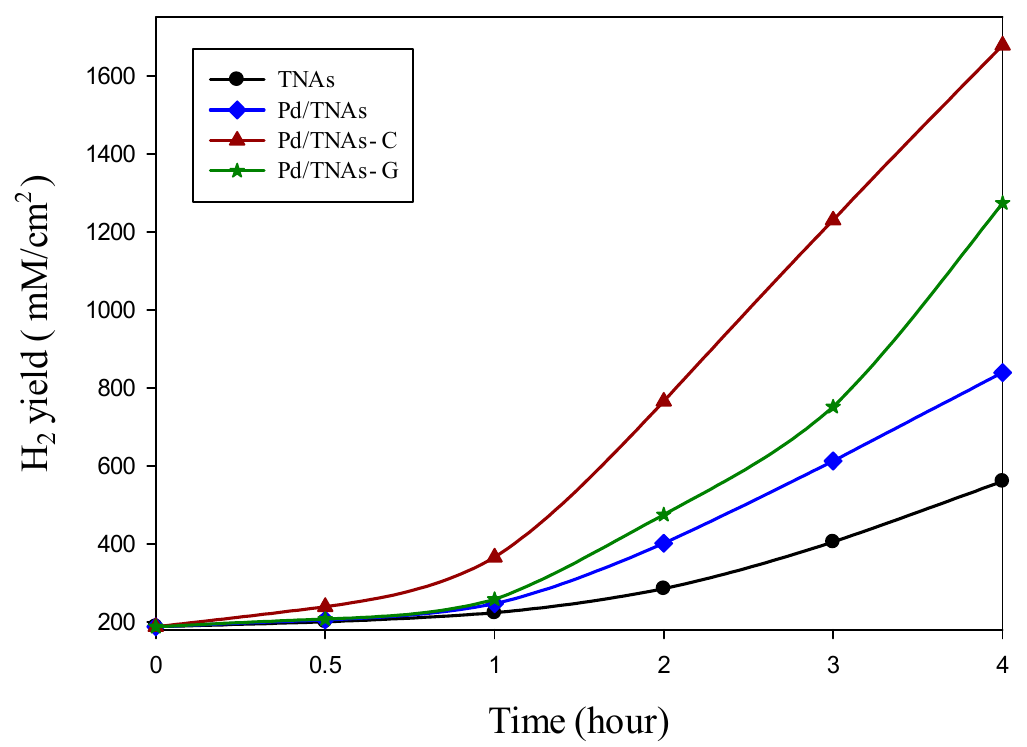
Figure 10. Comparison of hydrogen production by each material via the photoelectrochemical method.